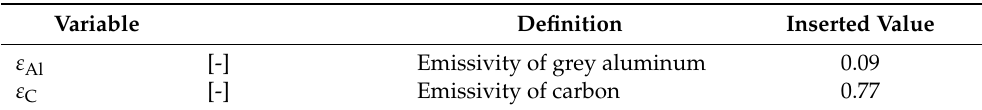
Table 10. Emissivity coefficient selected for the material phase inserted in the numerical solution, as published in [36].